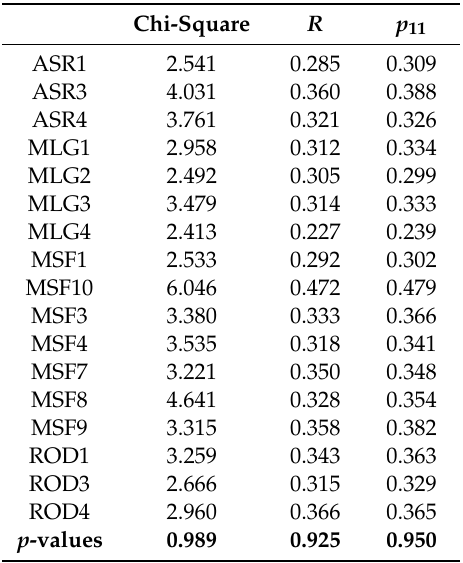
Table 5. The average values of the three indices (chi-square, R , and p 11 ) for each wine, along with the p -values from Friedman’s